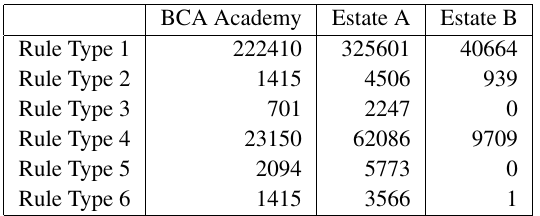
Table 1. Number of applications for each rule type in the 3rd storey model and the full BCA Academy